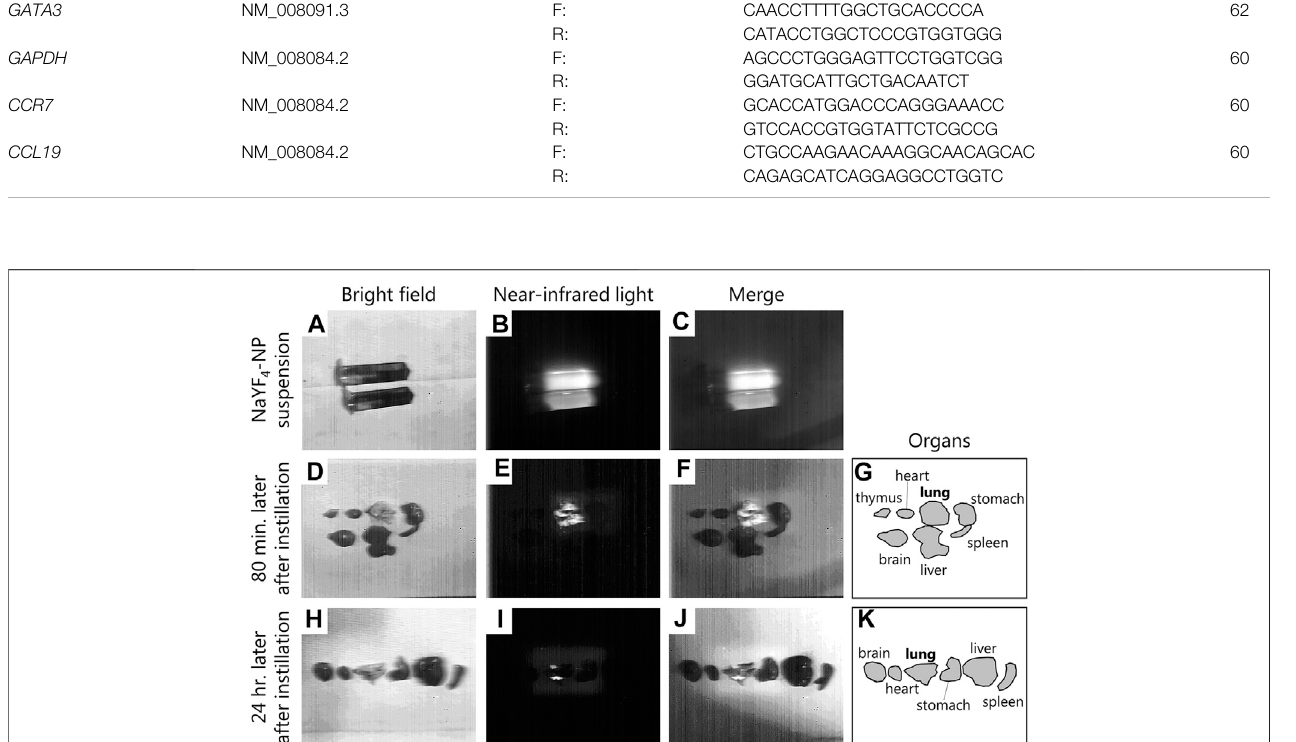
FIGURE 2 | Distribution of intranasally instilled nanoparticle throughout the lung in mice. (A – C) : Images of NaYF 4 : Yb 3+ , Er 3+ nanoparticle dispersions and their luminescenceunderirradiationwithnear-infraredlight(976 nm). (D – G) :Distributionofnanoparticlesineachorganafter80 minofintranasalinstillationofthesuspension. (H – K) : Distribution of nanoparticles in each organ after 24 h of intranasal instillation of the suspension. (A,D,E) : Pictures of nanoparticles dispersions and the organs captured under bright fi eld. (B,E,I) : Luminescence under irradiation with near-infrared light. (C,F,J) : Merge images of A and B, D and E, and H and I, respectively. (G,K) : Illustration showing the positions of the organs in the D and H pictures. Fluorescence images were obtained using a near-infrared camera with an InGaAs sensor (integration time: 500 ms), scanned under irradiation with near-infrared light (976 nm, 4.2 W) with a Galvano mirror.